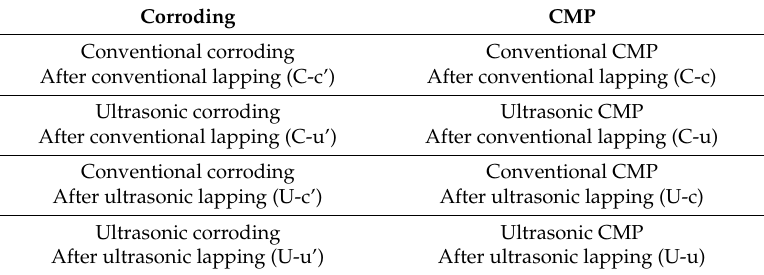
Table 1. Experimental schemes for corroding and CMP after lapping.